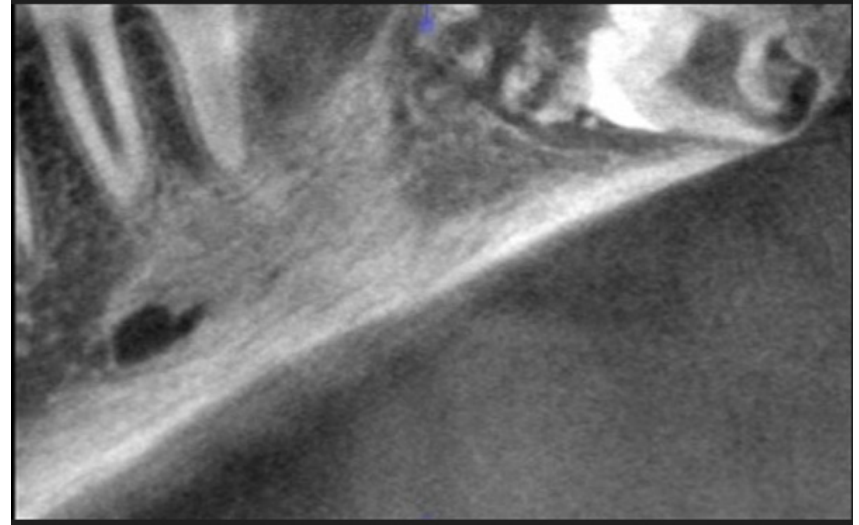
Figure 4. CBCT sagittal projection of the bone. Courtesy of Dr. W. Pawlak.